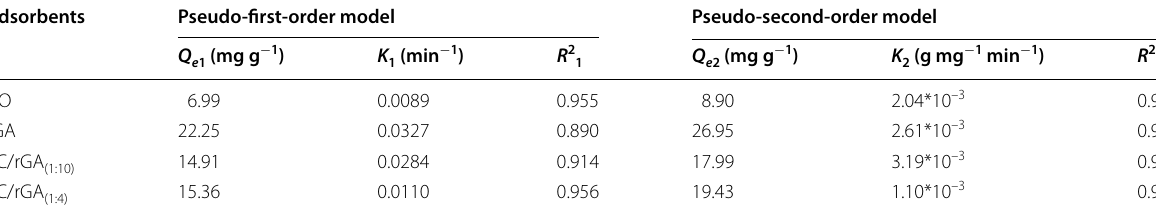
Table 1 Adsorption kinetic parameters of Cr(VI) on GO and aerogels